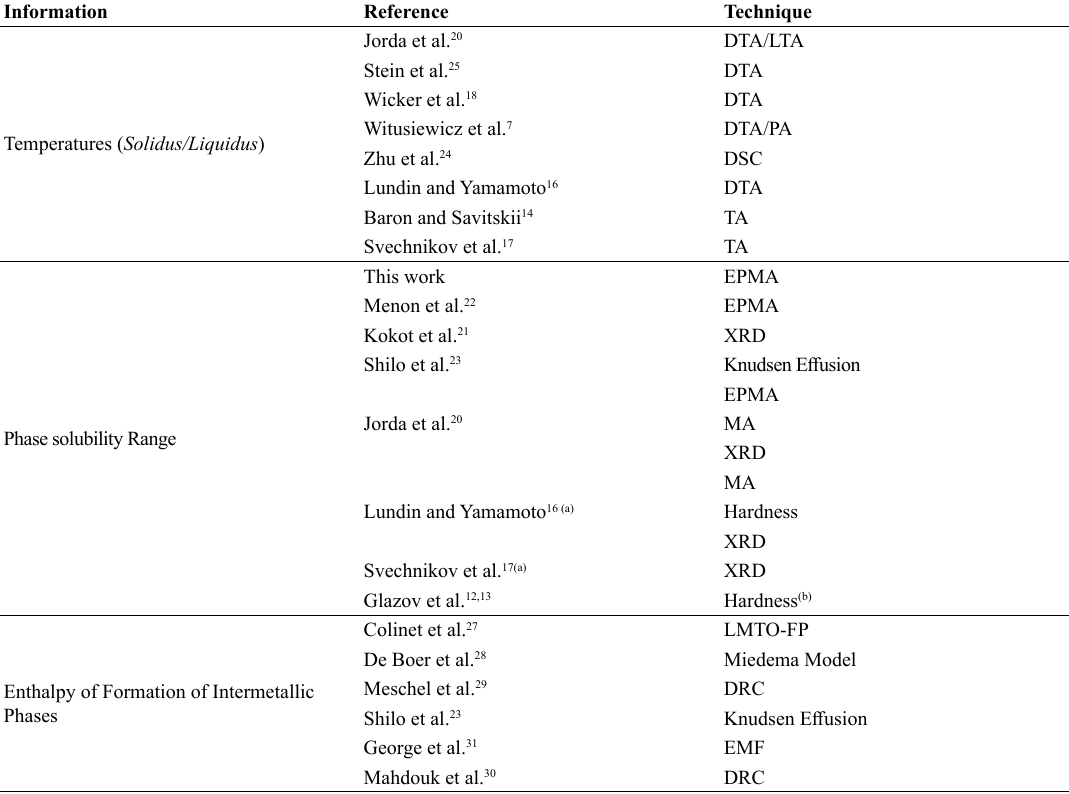
Table 1. Summary of Experimental information available for the Nb-Al